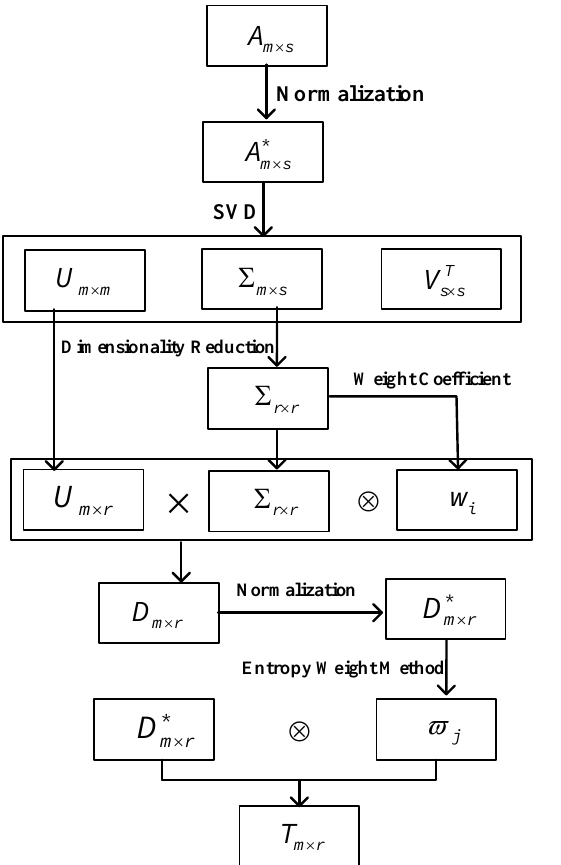
Figure 5. The flowchart of the Multi-Weight Singular Value Decomposition (MWSVD) feature extrac- tion